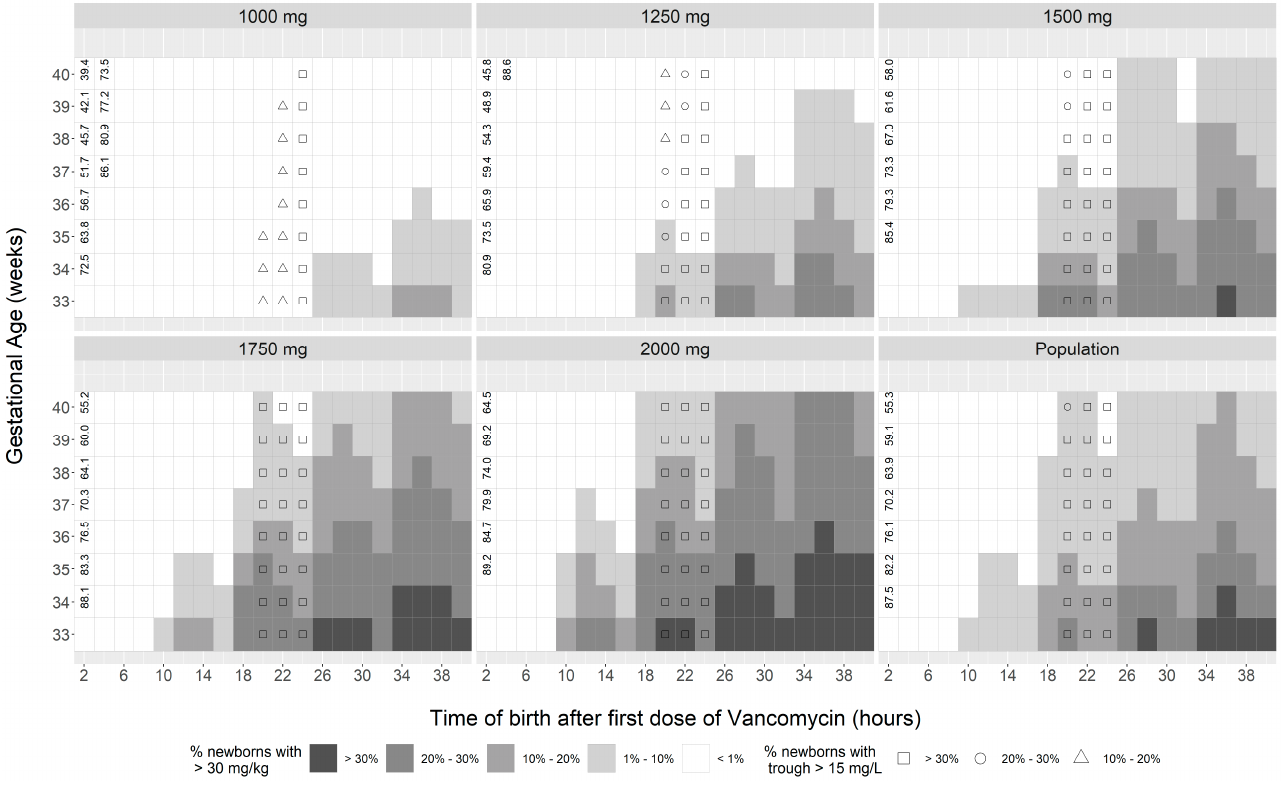
Figure 3. Newborn probability of vancomycin accumulation in excess of the 30 mg/kg dose cutoff. The shapes inside the tiles at 20, 22, and 24 h birth times represent probability of vancomycin concentrations > 15 mg/L after 3 doses administered. Numerical values in the boxes for birth times of 4 h or less indicate the probability of successful target achievement at the efficacy index of AUC > 39.1 mg·h/L not reaching the threshold of 90% (only <90% values are shown, for all others the PTA is >90%). As an example, a newborn with GA of 35 weeks born at 22 h after initiation of intrapartum prophylaxis to a mother who received 3 doses of the 2000 mg prophylactic regimen is at 20% to 30% risk of accumulating vancomycin in excess of the 30 mg/kg cutoff and is at >90% chance of achieving the target efficacy index of AUC > 39.1 mg·h/L and has the probability > 30% to have a serum trough concentration of >15 mg/L 24 h after initiation of intrapartum prophylaxis.